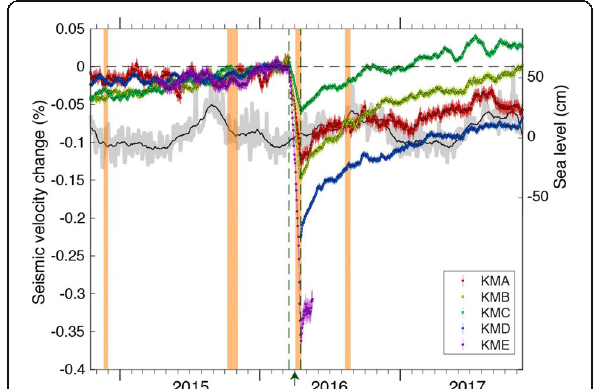
Fig. 4 Temporal variation of the average seismic velocity in each node (colored dots). Error bars correspond to the errors calculated from the standard deviations of seismic velocity change using Eq. (5) by error propagation. The arrow at the bottom indicates the day of the 2016 Off-Mie earthquake, and the vertical dashed lines show the 30-day time window influenced by the mainshock. Gray and black curves represent sea levels at station OW computed by daily and 30-day stacking of hourly data, respectively. Orange areas represent the periods of slow slip events reported by Araki et al.